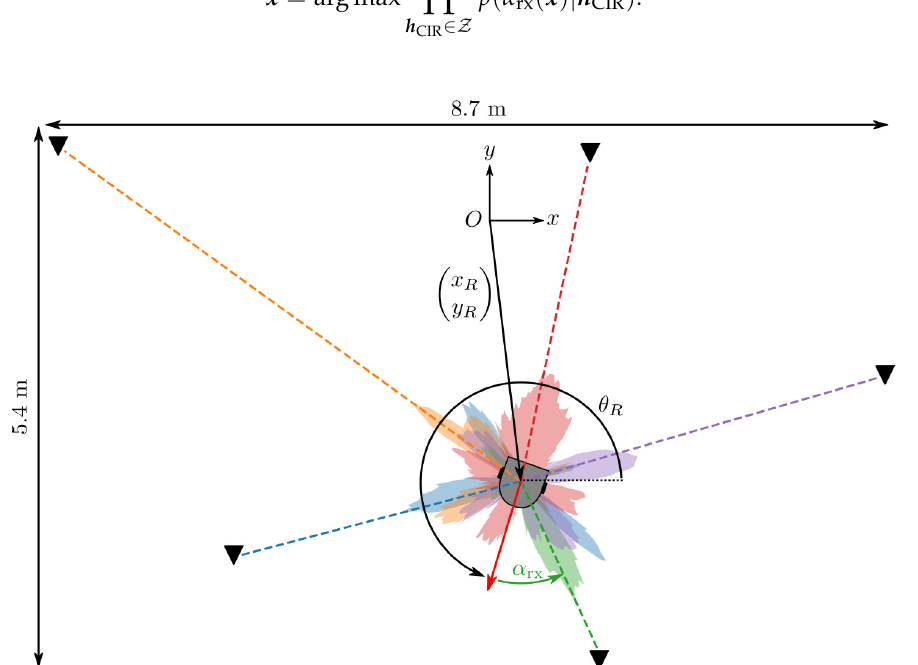
Figure 8. A robot can localize itself with respect to anchors having known locations by maximizing the AOA likelihood as given by the neural network. The predicted AOA a-posteriori probability distributions for each anchor are shown in different